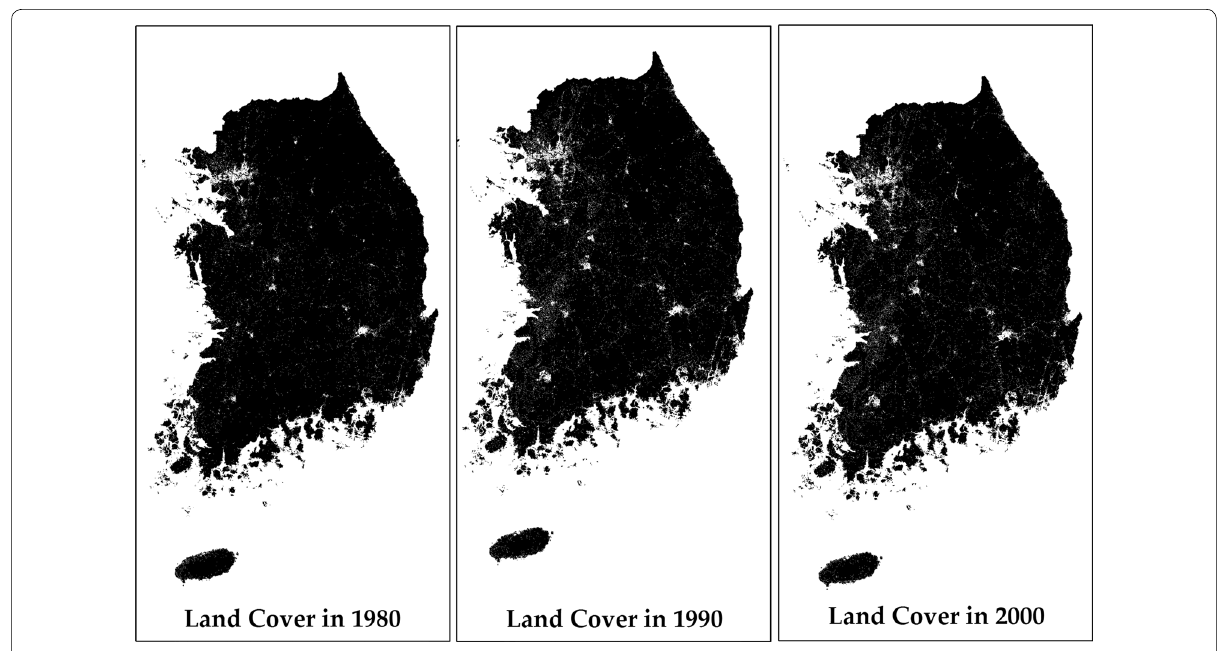
Fig. 1 Impervious cover changes in 1980 through 2000